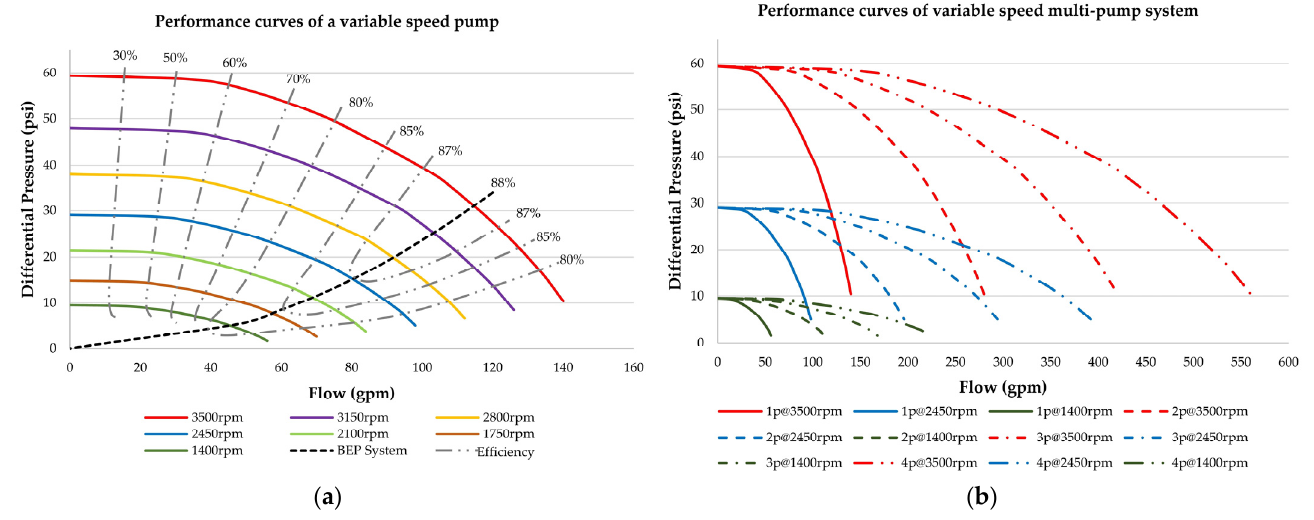
Figure 2. Performance curves in centrifugal pumps with speed variation: ( a ) in a single pump; ( b ) in a system of multiple pumps in parallel.